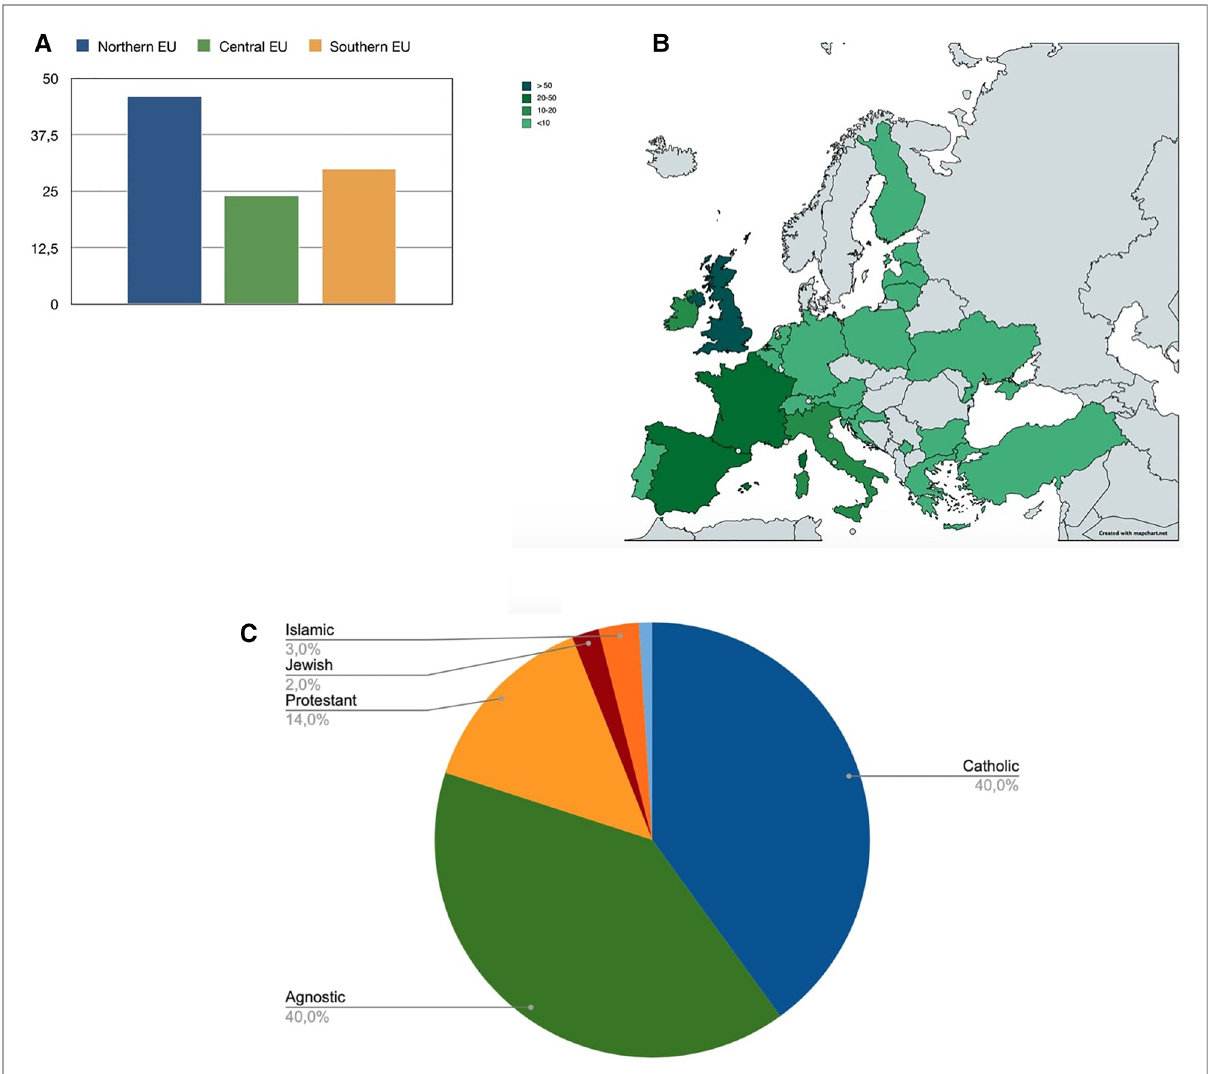
FIGURE 2 Distribution of respondents by European region (%, fi gure A ) and country (N, fi gure B ). EU (Europe). ( C ) Distribution of respondents by religious